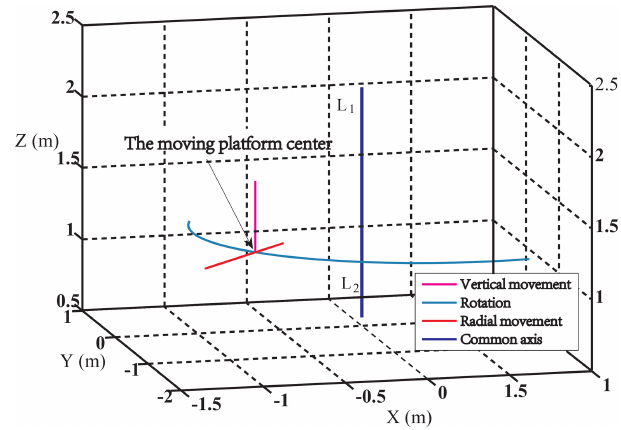
Figure 2. The motion trajectory of moving